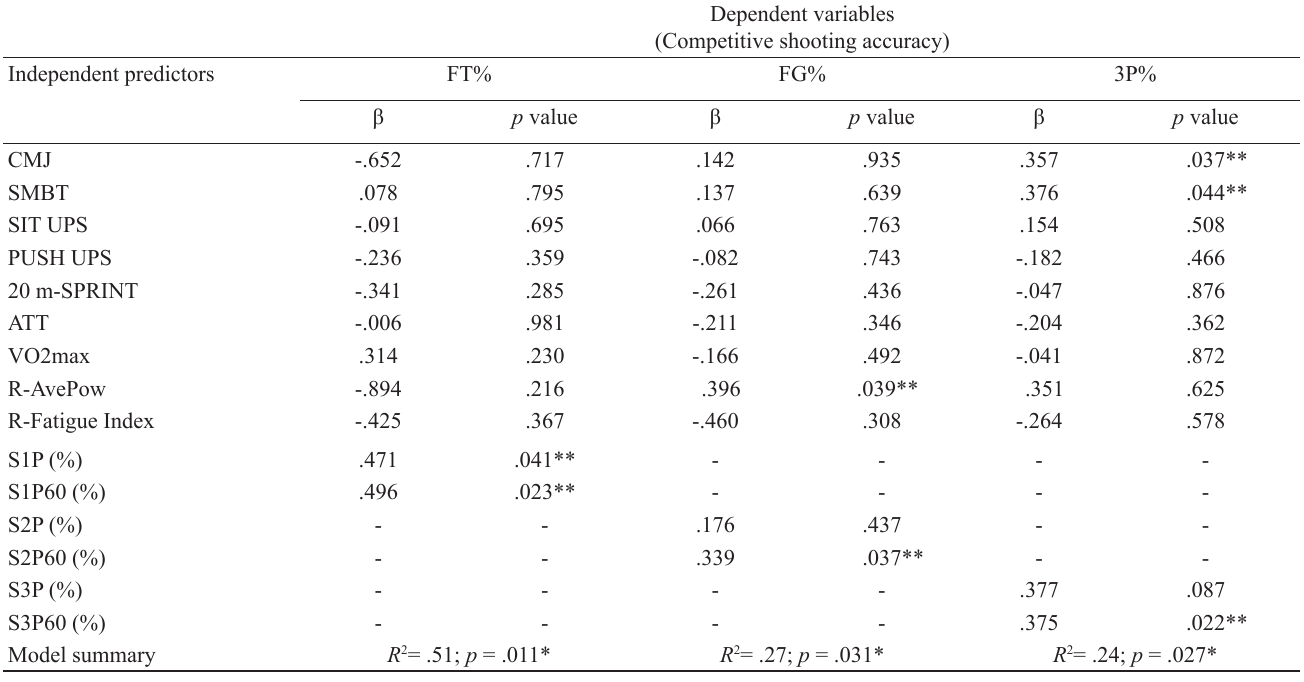
3. The relationship between physical fitness, basketball shooting skill tests and competitive shooting accuracy for n = 38.